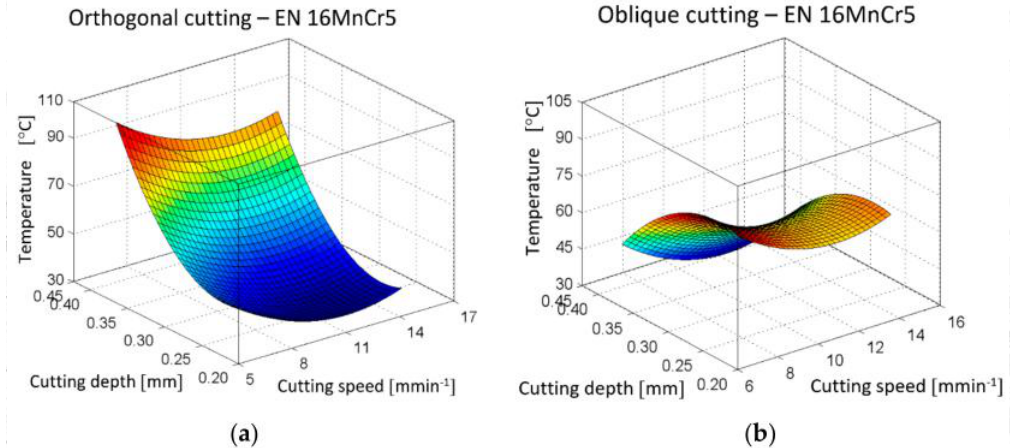
Figure 8. The dependence of temperature T on cutting speed v c and cutting depth a p , ( a ) Orthogonal cutting; ( b ) oblique